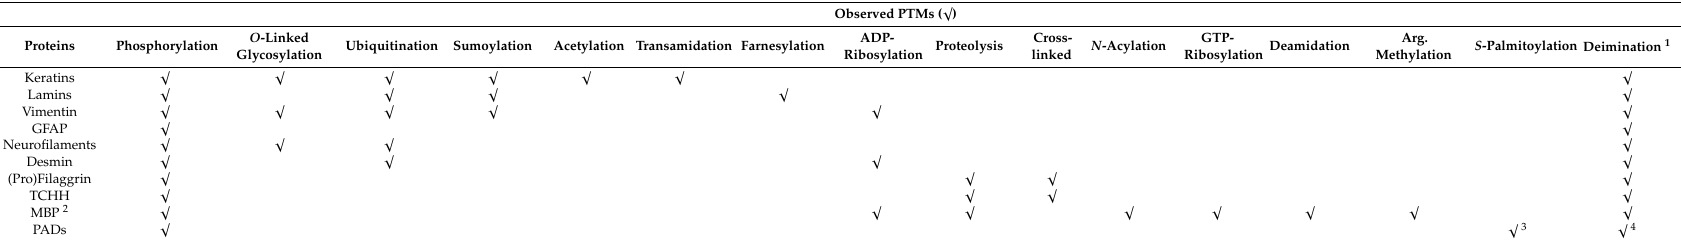
Table 2. Examples of post-translational modifications (PTM) of intermediate filament proteins, intermediate filament associated proteins and